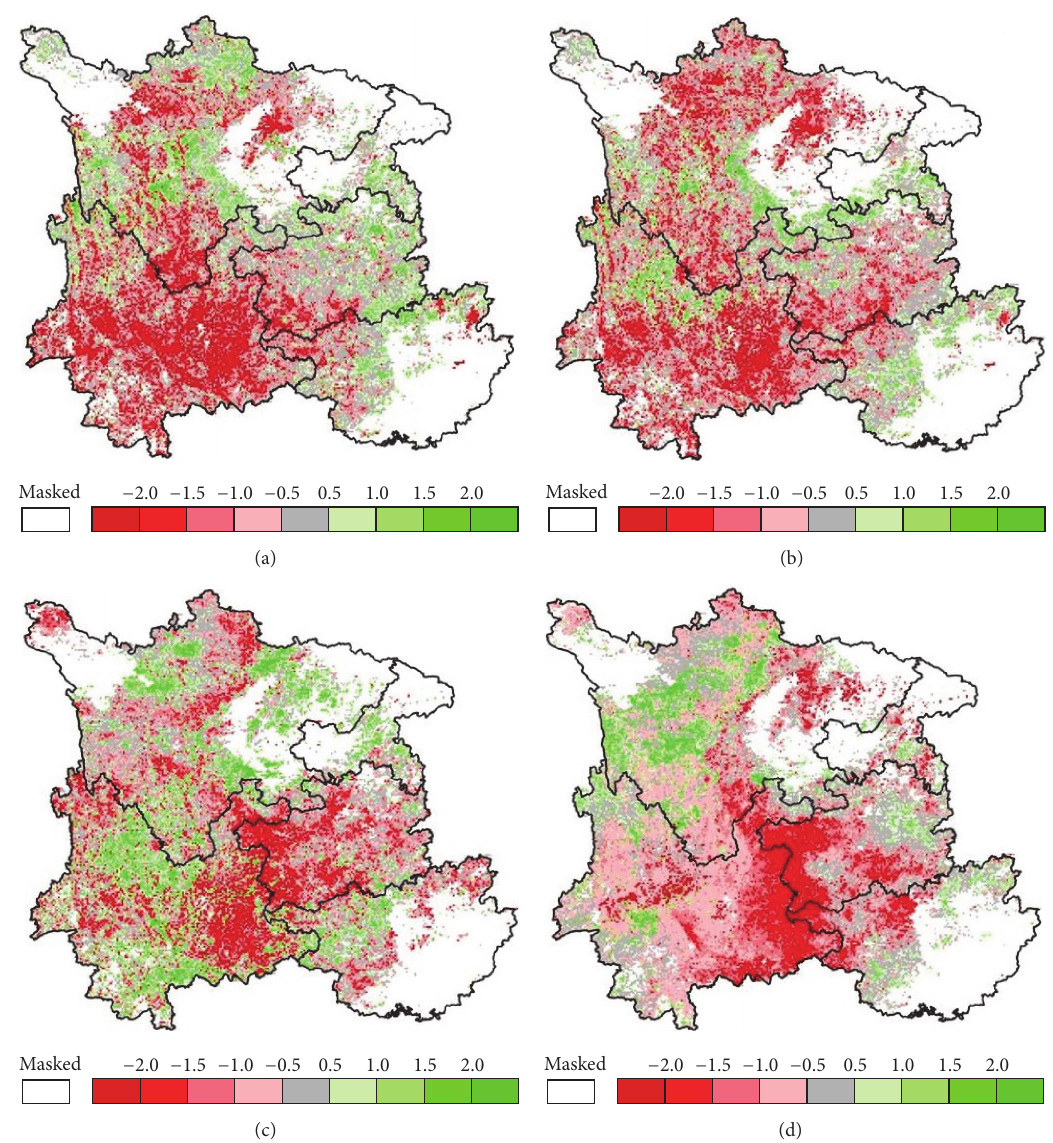
Figure 4: Spatial distributions of standardized anomalies: (a) for NDVI, (b) for EVI, (c) for NDWI, and (d) for LST during the drought period in vegetated areas, which suffered from the 2009/2010 drought over southwestern